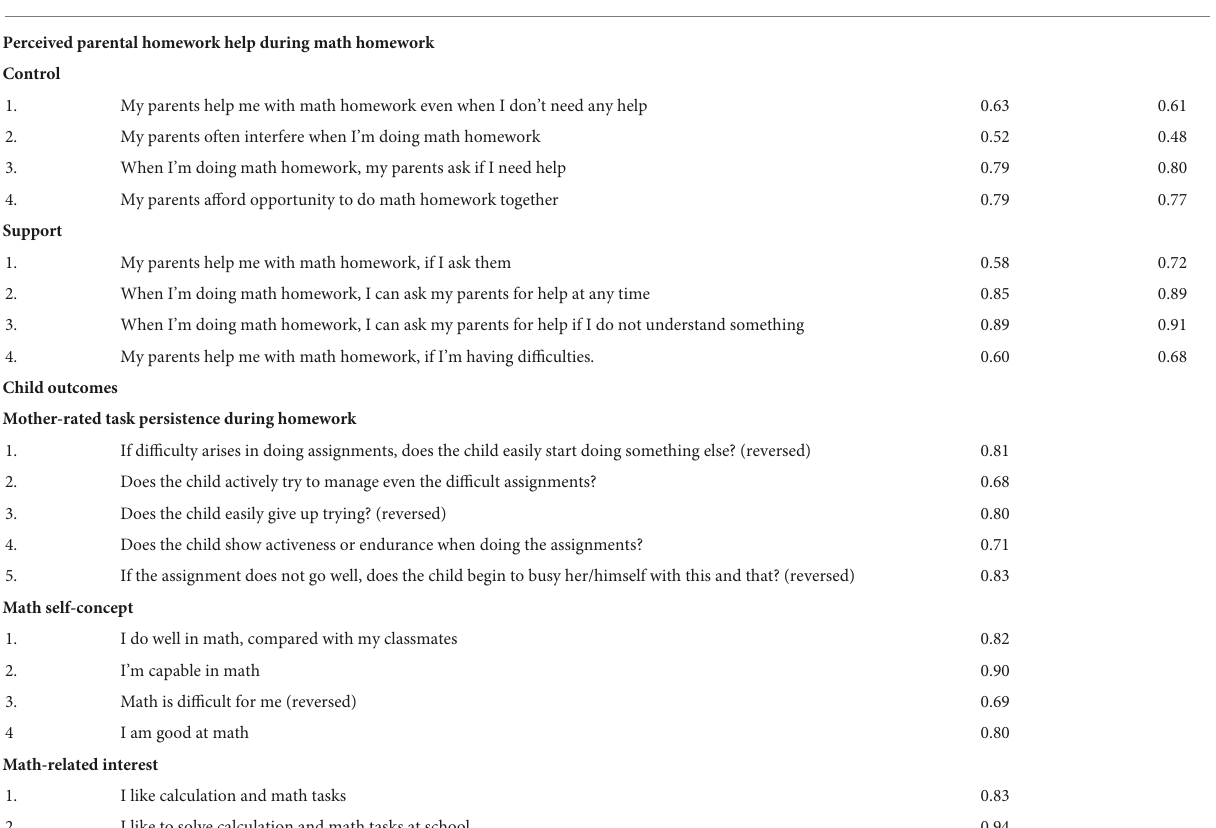
TABLE A1 Factor loadings (standardized estimates) of the confirmatory factor analyzes.